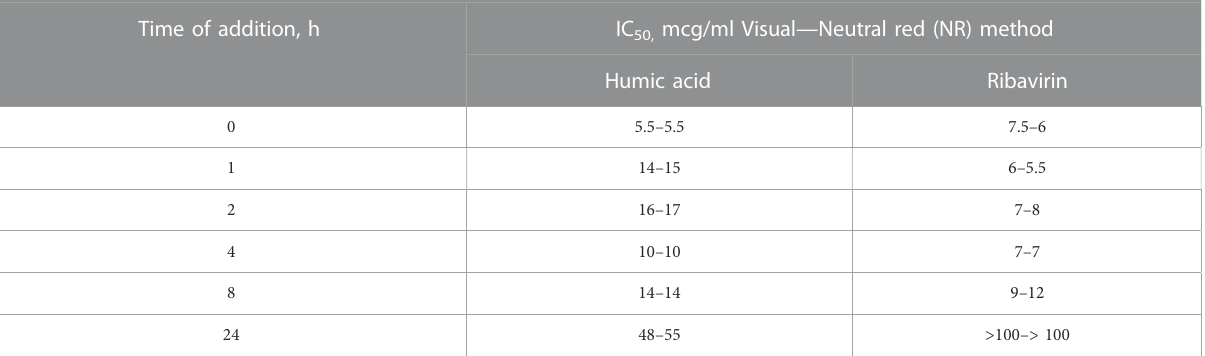
TABLE6IntheTimeofAdditionstudypresented,humicacidorthereferencecompound,ribavirin,isaddedtovirus-infectedcellsatdiscretetimepoints.Time point “ 0 ” represents prior to infection. The most effective antiviral effect is observed when cells were pretreated with humic acid. Though there was a decrease inthe antiviral effect for humic acid between 1 hand24 hrelative to time “ 0, ” ribavirin lostall activity by24 hwhereas humic acid remained active. Since the time from viral adsorption to the shedding of new in fl uenza virus in vitro can begin after 6 h (World Health Organization, 2022), the IC 50 data for humicacidat24 hsuggeststhathumicacidalsolimitsnewvirusadsorptionafteracycleofviralshedding.Giventhatcells invitro werecontinuouslyexposed to humic acid material, this reasoned explanation is most